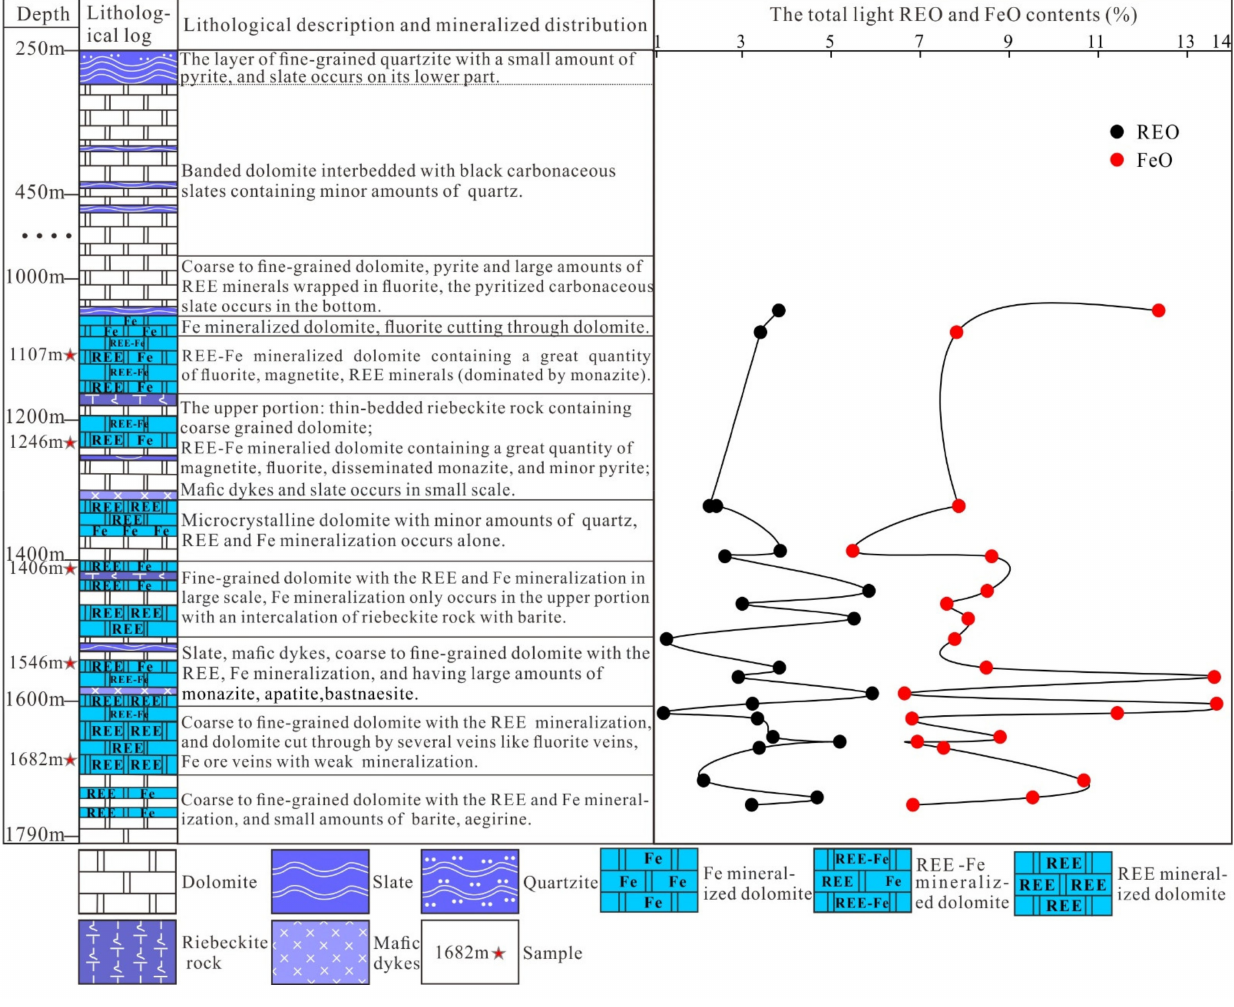
Figure 2. Lithological column and identified mineralization of the borehole (up to 1776 m) of the Eastern Orebody in the Bayan Obo deposit. Note that “REO” is the total rare earth oxides and “ · · · · ” represent the repeated lithology (dolomite) without obvious change between depth of 450 and 1000